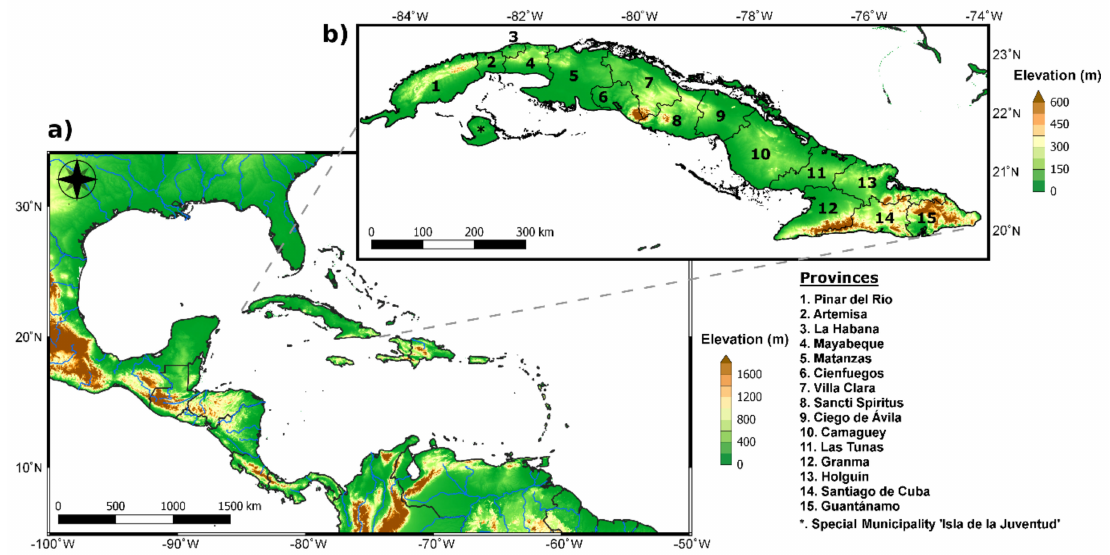
Figure 1. Geographic location of Cuba in the Caribbean region ( a ). The elevation is shaded in green– brown (in meters above sea level) from the HydroSHEDS project [41]. The boundaries of the 15 provinces of Cuba are delimited by black lines ( b